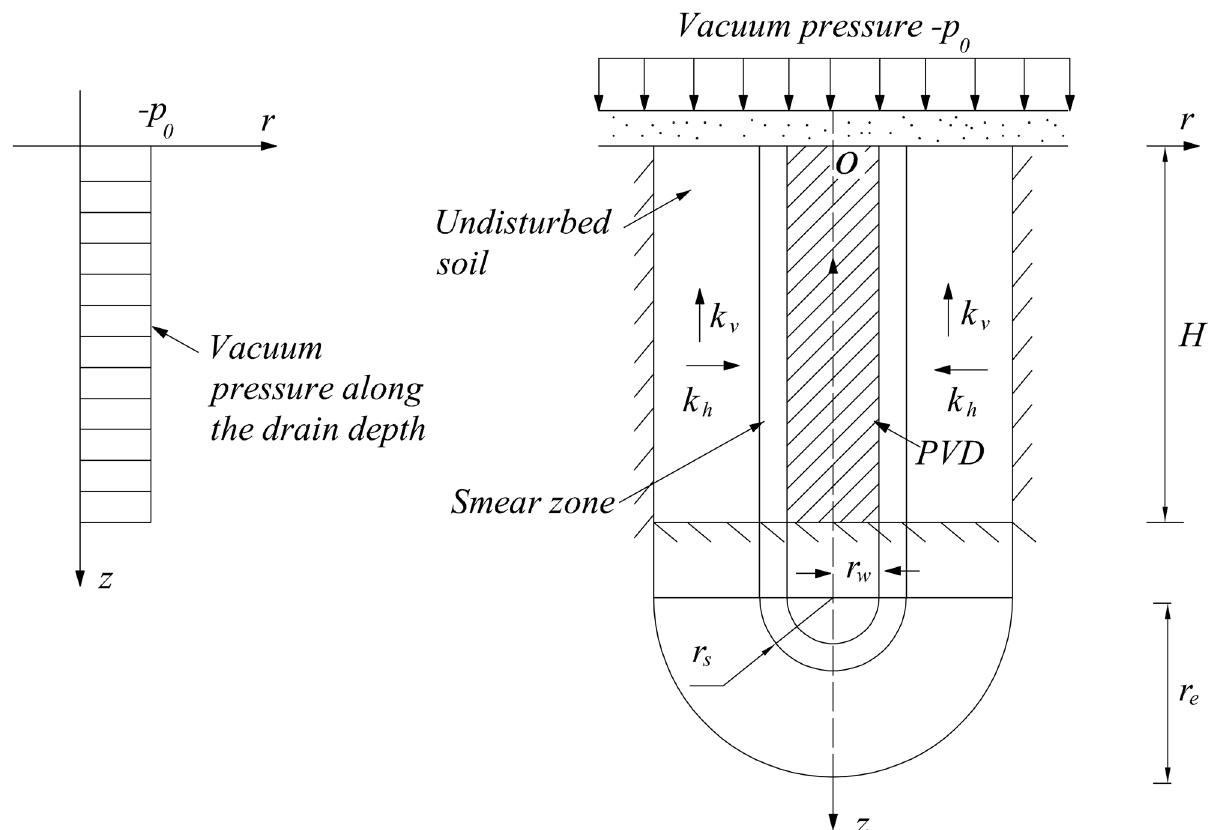
Fig 2. Schematic diagram of the vacuum preloading method with a